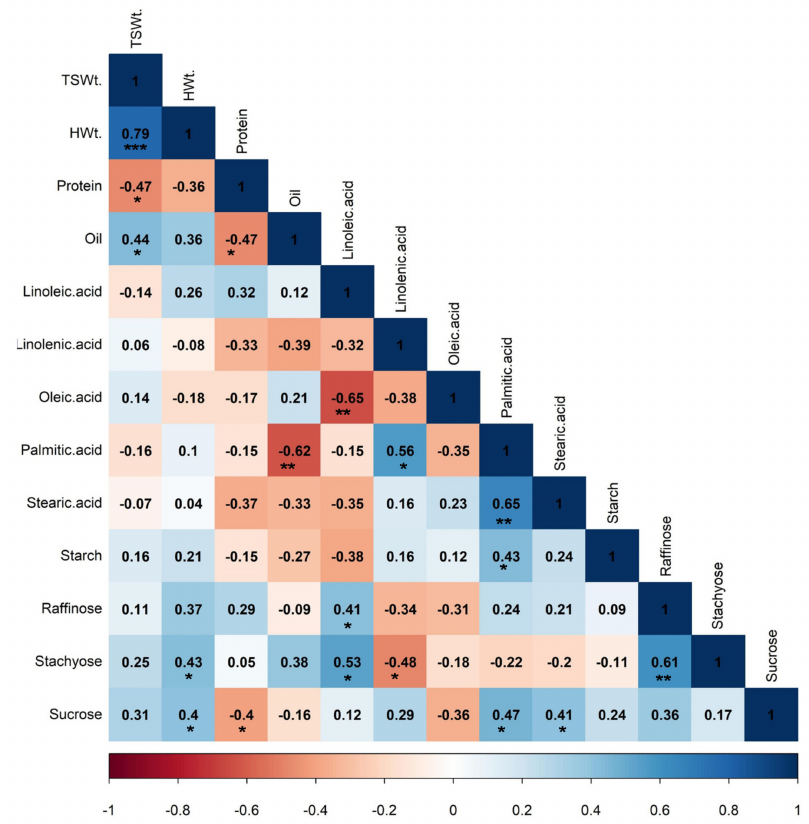
Figure 4. Pearson’s correlation coefficients between soybean yield and quality parameters. The high and low intensity of color represent strong and weak relationships (blue for positive and red for negative) between a pair of parameters, respectively. Values closer to one indicate a strong correlation, and a value closer to zero indicates a weaker relationship between the two variables. * p < 0.05, ** p < 0.01, *** p < 0.001 indicate significant correlation between pair of traits. TSWt.—total seed weight plant − 1 ; HWt.—100-seed